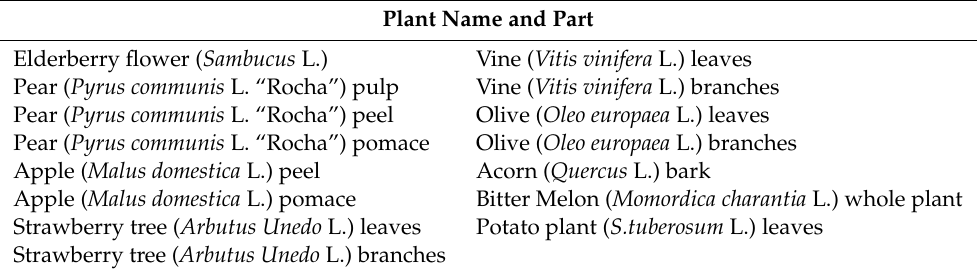
Table 1. Listof all the natural sources screened in this study for potential anti-browning e ff ect. Plant Name and Part Elderberry flower ( Sambucus